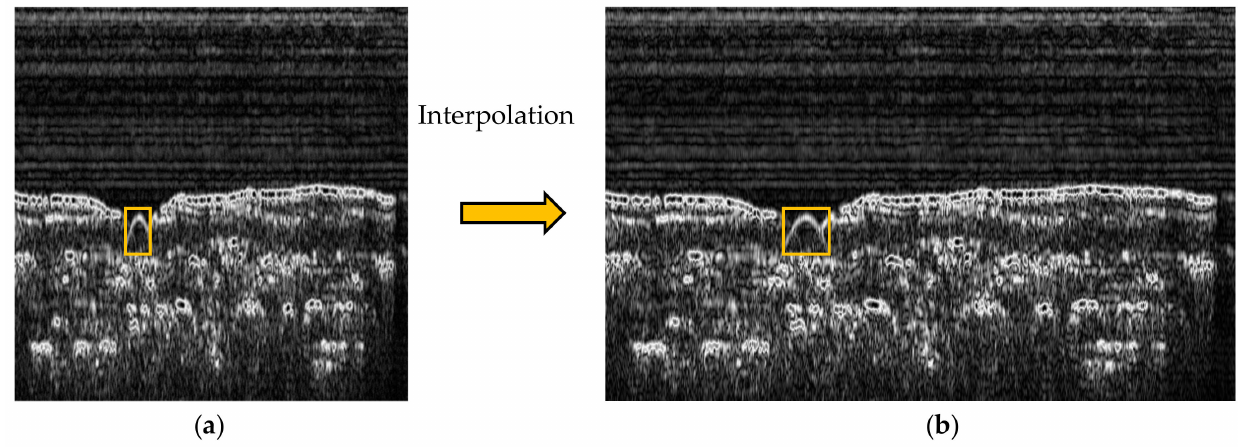
Figure 6. Raw SBP waterfall image interpolation. ( a ) Raw waterfall image collected by C-boom; ( b ) interpolated